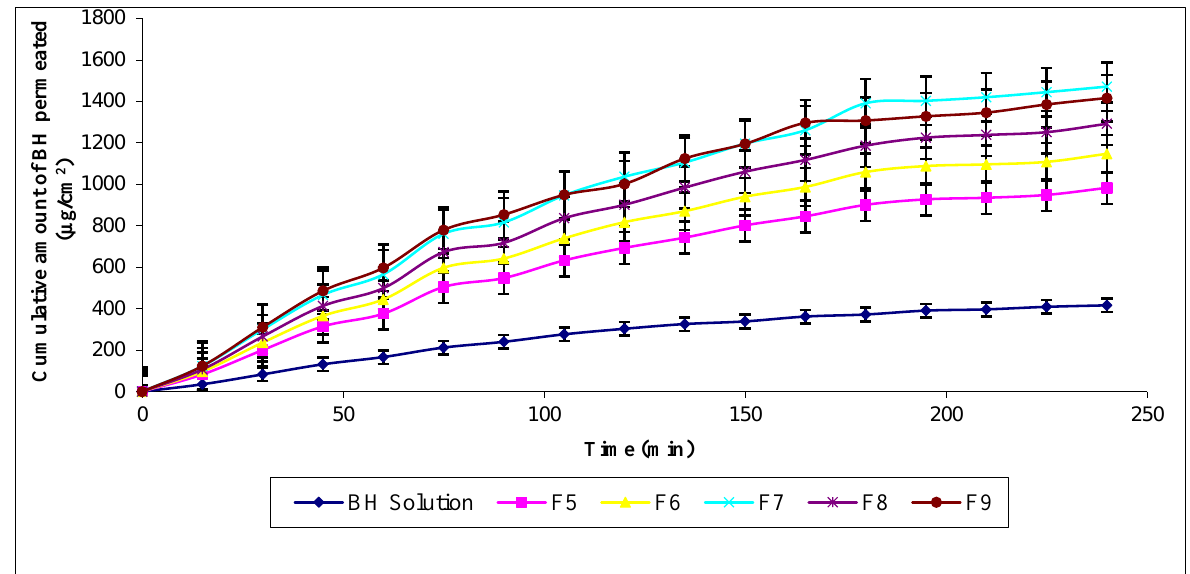
Figure 4. Ex vivo permeation profiles of BH hydrogels containing permeation enhancers compared to F5 (lacking permeation enhancer) and BH solution by iontophoresis through rat skin.